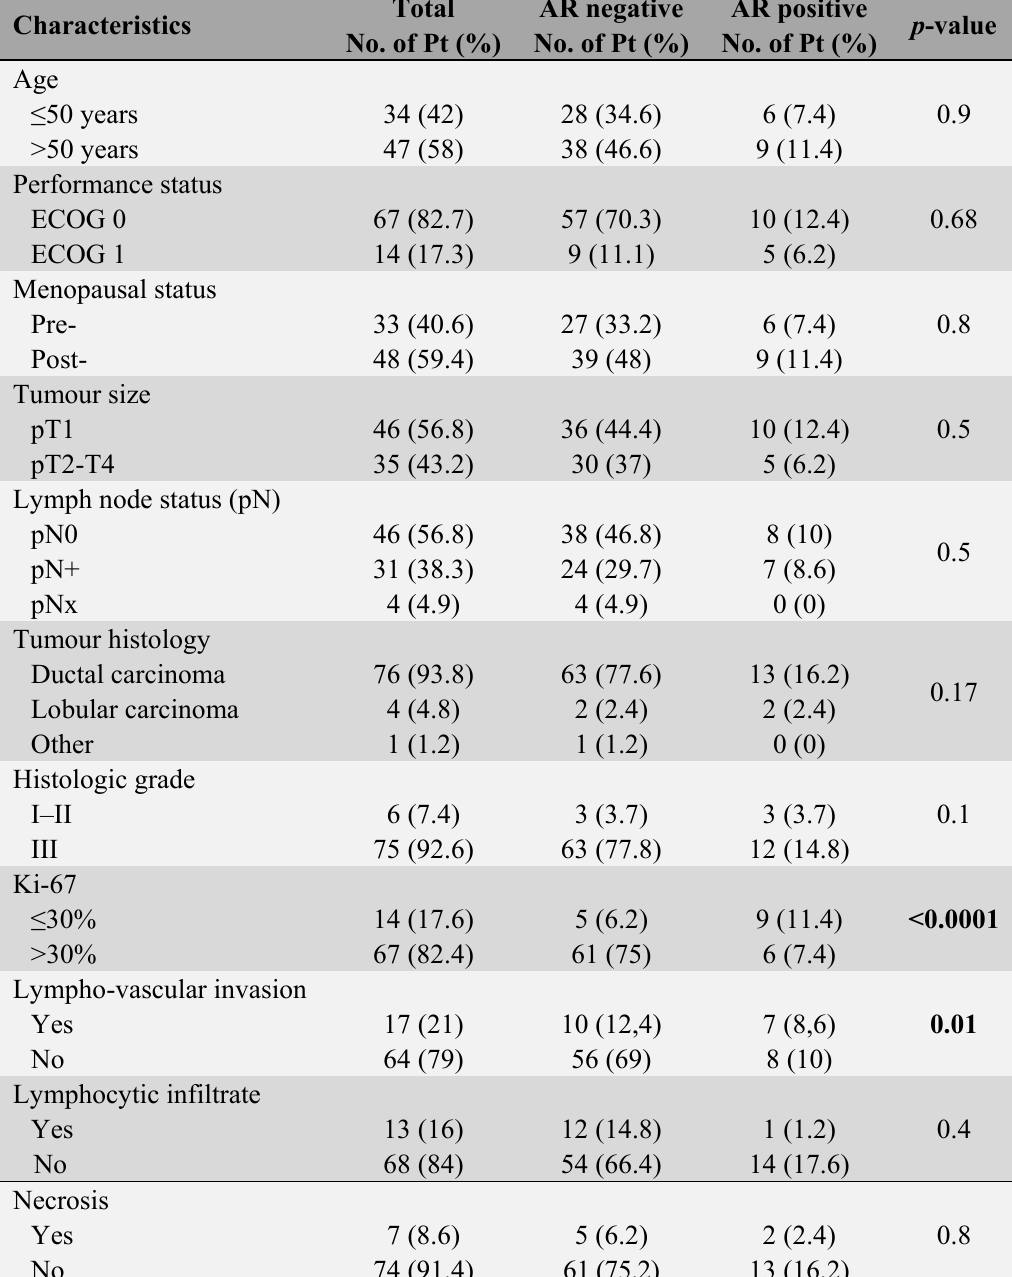
Table 1. Baseline characteristics of the 81 patients with early